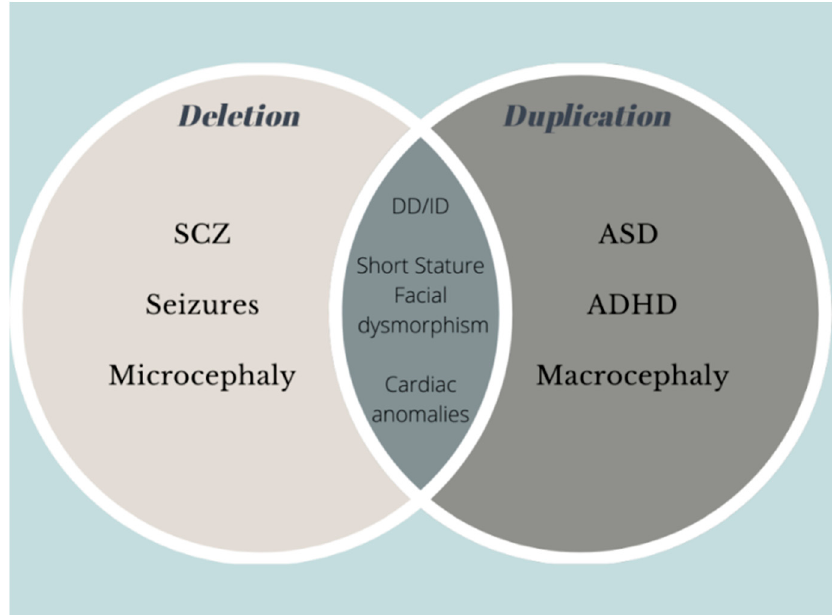
Figure 3. Venn diagram of phenotype association with 1q21.1 microdeletions and microduplication.